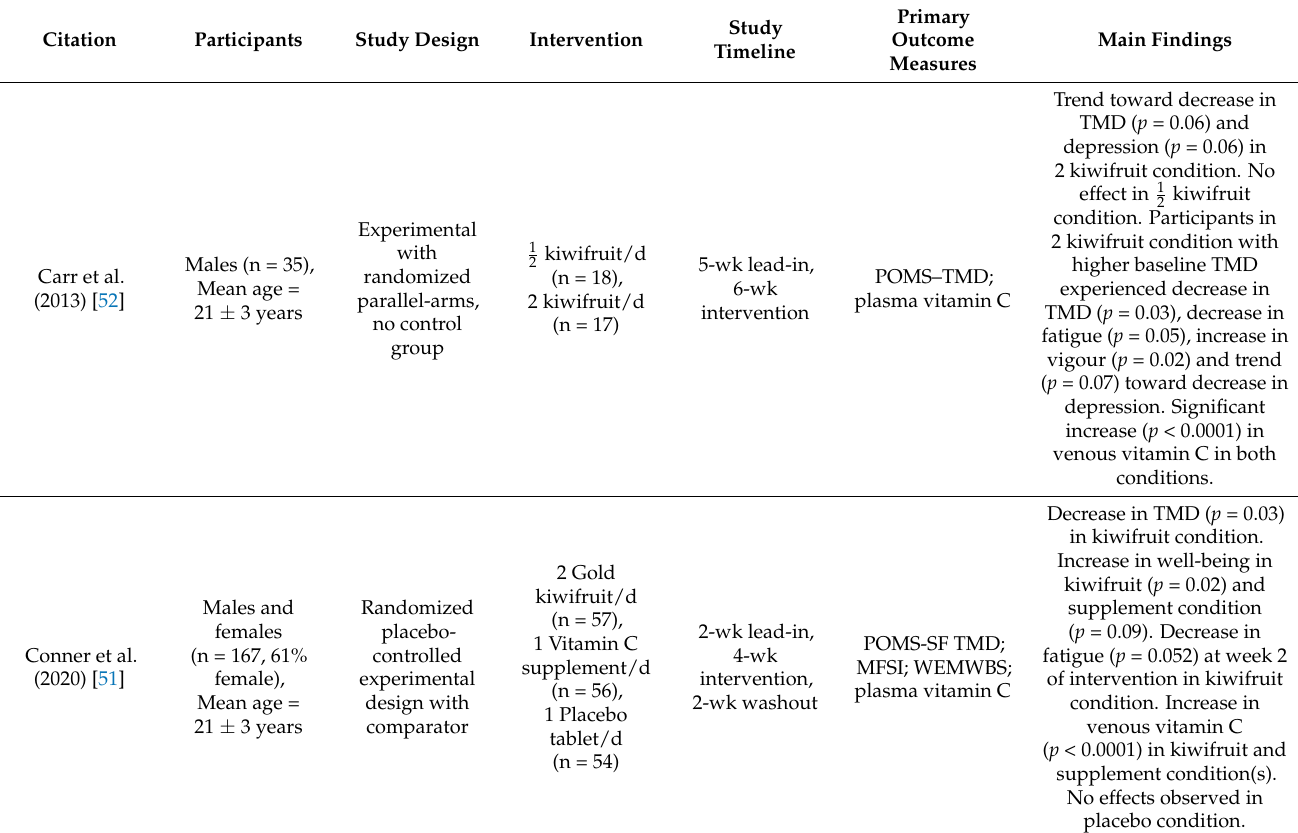
Table 2. Summary of included